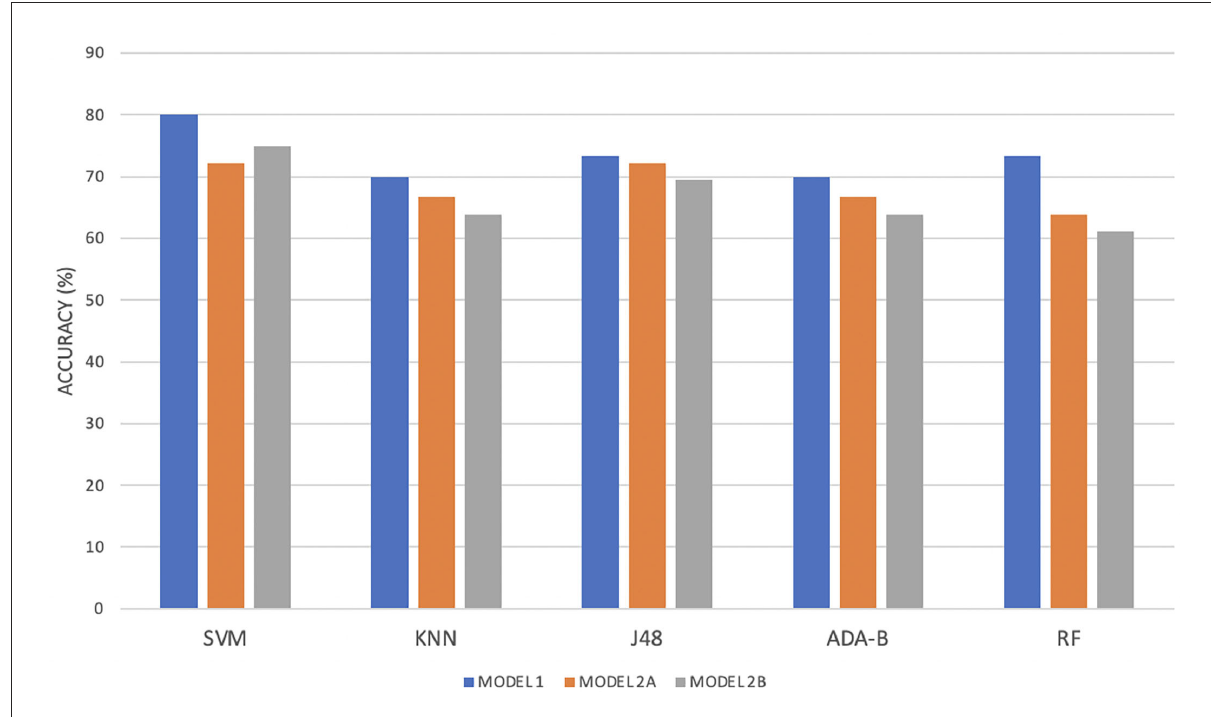
FIGURE2 Level of agreement among classifiers’ scores for each model of the